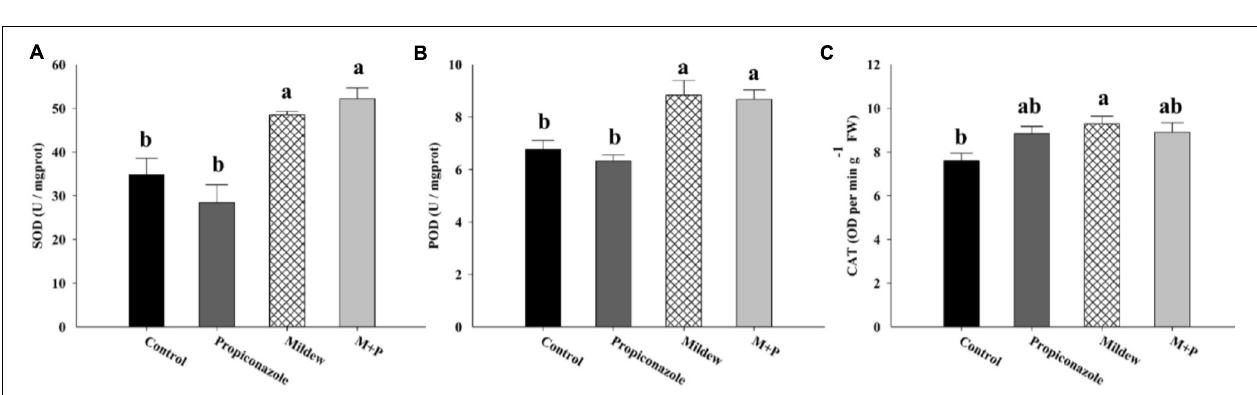
FIGURE 6 | The activity of three antioxidant enzymes: SOD (A) , POD (B) , and CAT (C) among the four treatments. Different letters above the bars indicate significant difference among different treatments and the error bars is ± SE bars (three biological replicates, P < 0.05, Tukey’s HSD test).